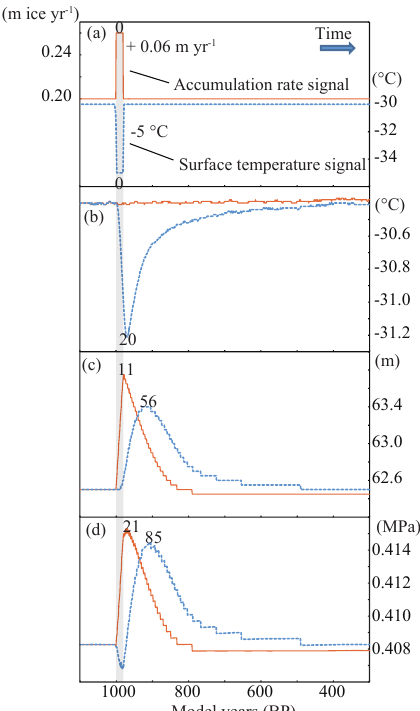
Figure 12. Two model experiments for the effects of surface tem- peratures and accumulation rates on the overloading pressure at the bubble close-off depth. (a) Input data for the accumulation rate (0.2miceyear − 1 ) and surface temperature ( − 30 ◦ C) with 20-year anomalies ( + 0.06myear − 1 and − 5 ◦ C) for the years 1000–981BP, respectively. When one input was used for an experiment, the other was set constant. Zero in (a) indicates the central year (model year 990BP) of the anomalies. (b) Temperatures at the bubble close-off depth. (c) Firn thickness. (d) Overloading pressures at the bubble close-off depth. The orange line is the accumulation rate experi- ment, and the blue line is the temperature experiment. Numbers on peaks in (b – d) are the lag in years from the central year of the initial anomalies in (a)